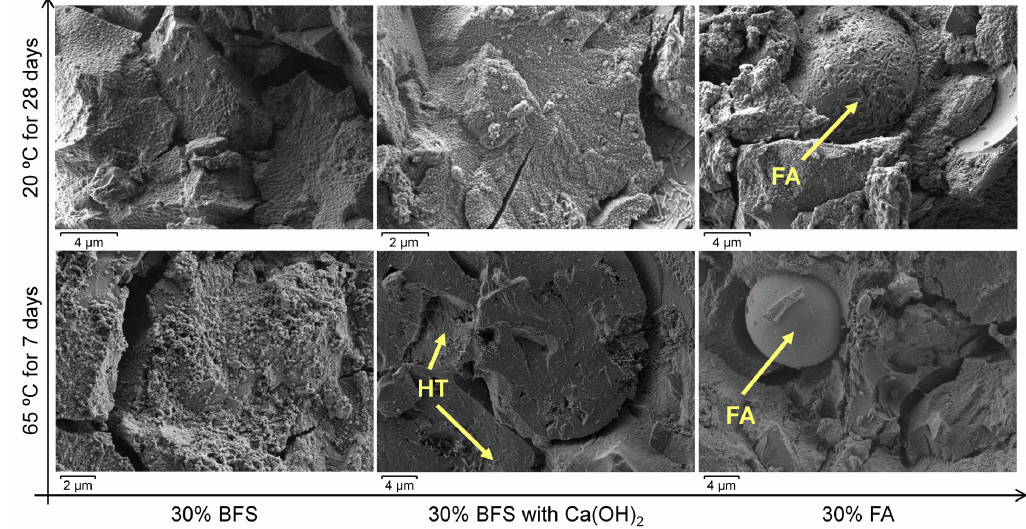
Figure 13. The field emission scanning electron images of the CSW blended pastes prepared with 30 wt % BFS (with and without Ca(OH) 2 ) and 30 wt % FA, cured at 20 °C for 28 days and at 65 °C for 7 days. FA: fly ash particles, HT: hydrotalcite, N–(C)–A–S–H: alkali-activated gel.